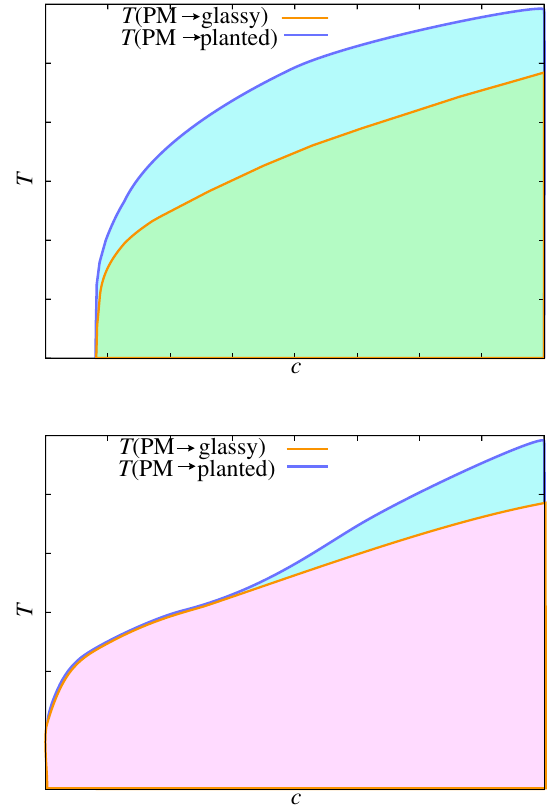
FIG. 9. Qualitative phase diagram for a “ standard ” model with a continuous transition (upper panel) and for the replicated coloring model (lower panel). While for a standard continuous model, the temperature at which the PM state becomes unstable toward the planted state is always higher than the temperature of the instability toward a random glassy state, for the replicated model below a certain connectivity, the two temperatures coincide. As in Fig. 9, in the blue regions both a MCMC algorithm and BP can nucleate the planted solution, while in the green one, MCMC algorithms get trapped in glassy states while BP is able to find the planted one. In the diagram of the replicated model, a new previously unseen region, colored pink, appears where both a MCMC algorithm and BP are trapped by a glassy